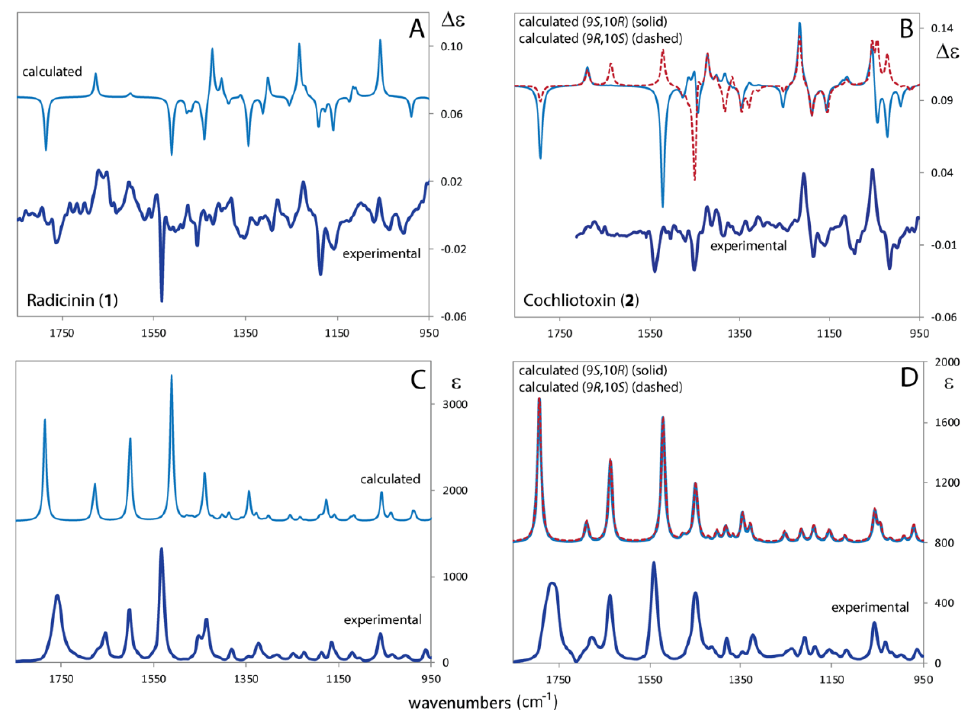
Figure 4. Comparison of experimental and calculated VCD and IR spectra of radicinin ( 1 ) (panels A , C ) and of cochliotoxin ( 2 ) (panels B , D ). For ( 2 ) the two possible diastereomers have been calculated. DFT/B3LYP/TZVP/PCM(CHCl 3 ) level of theory. Applied scaling factor is 0.99. Calculated IR spectra are divided by factor of 3.